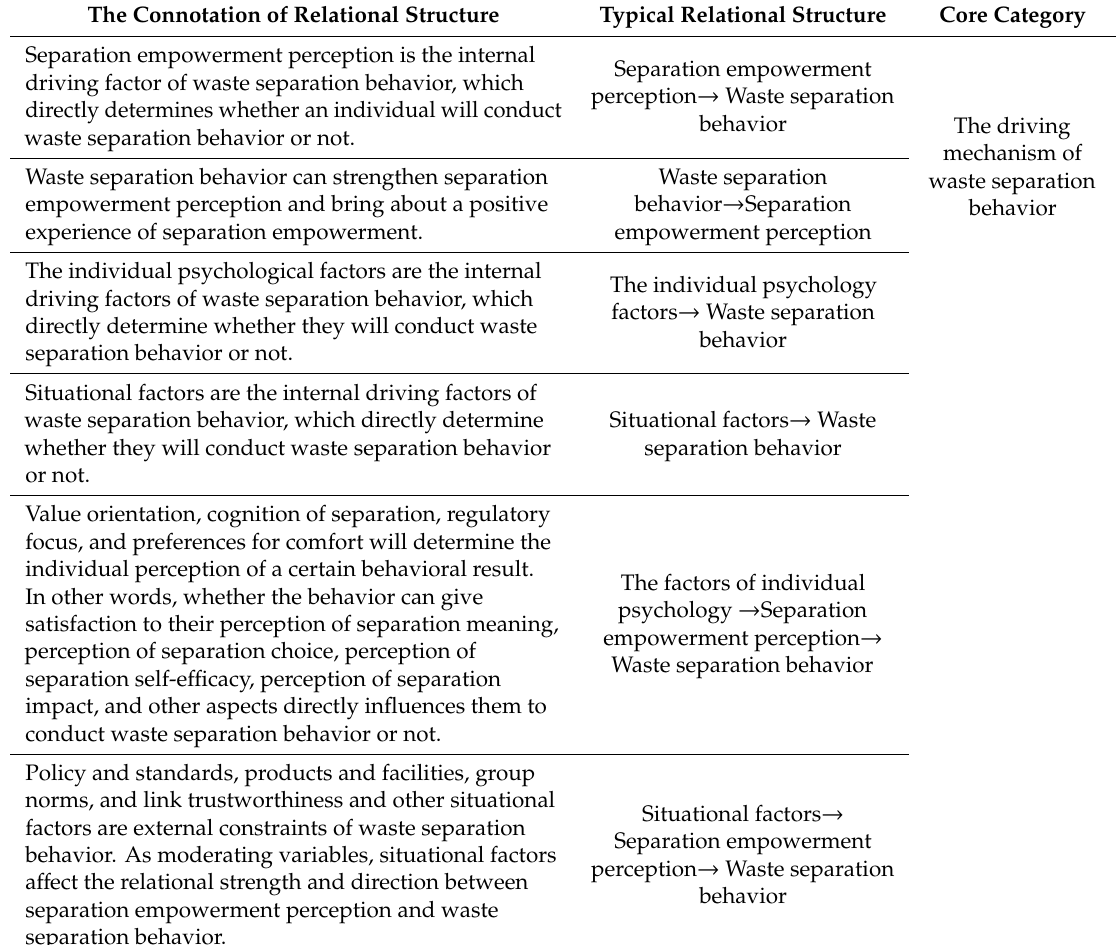
Table 6. Results of selective